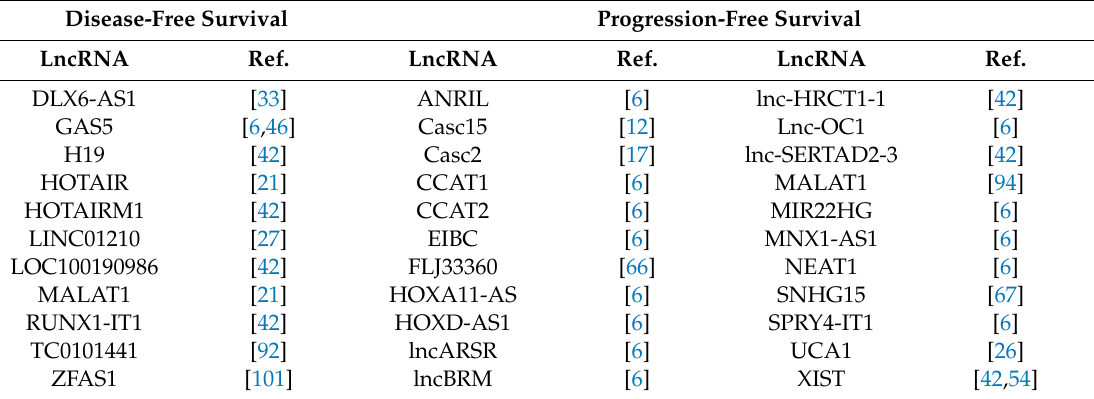
Table 3. LncRNAs associated with patients’ disease-free and progression-free survival. Disease-Free Survival